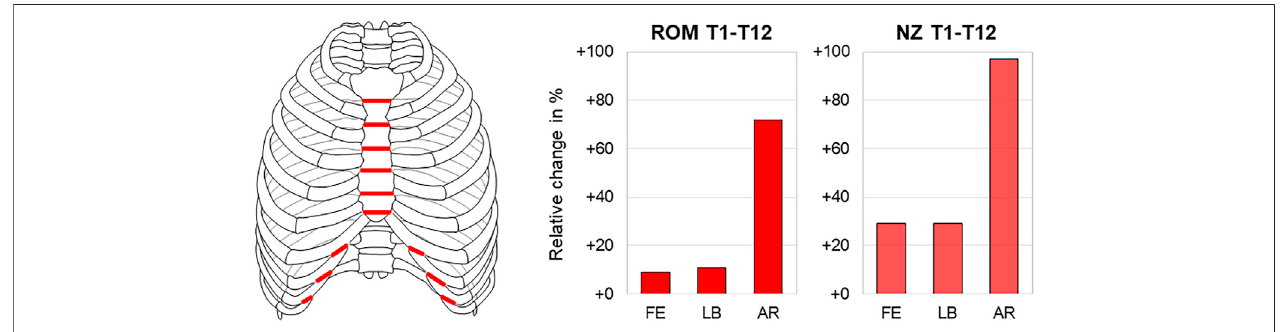
FIGURE7| Transverseanteriorintersegmentaltransection.Therelativerangeofmotion(ROM)andneutralzone(NZ)changesofthethoracicspine(T1-T12)during fl exion/extension (FE), lateral bending (LB), and axial rotation (AR) after transverse anterior intersegmental transection according to Liebsch and Wilke (2020).